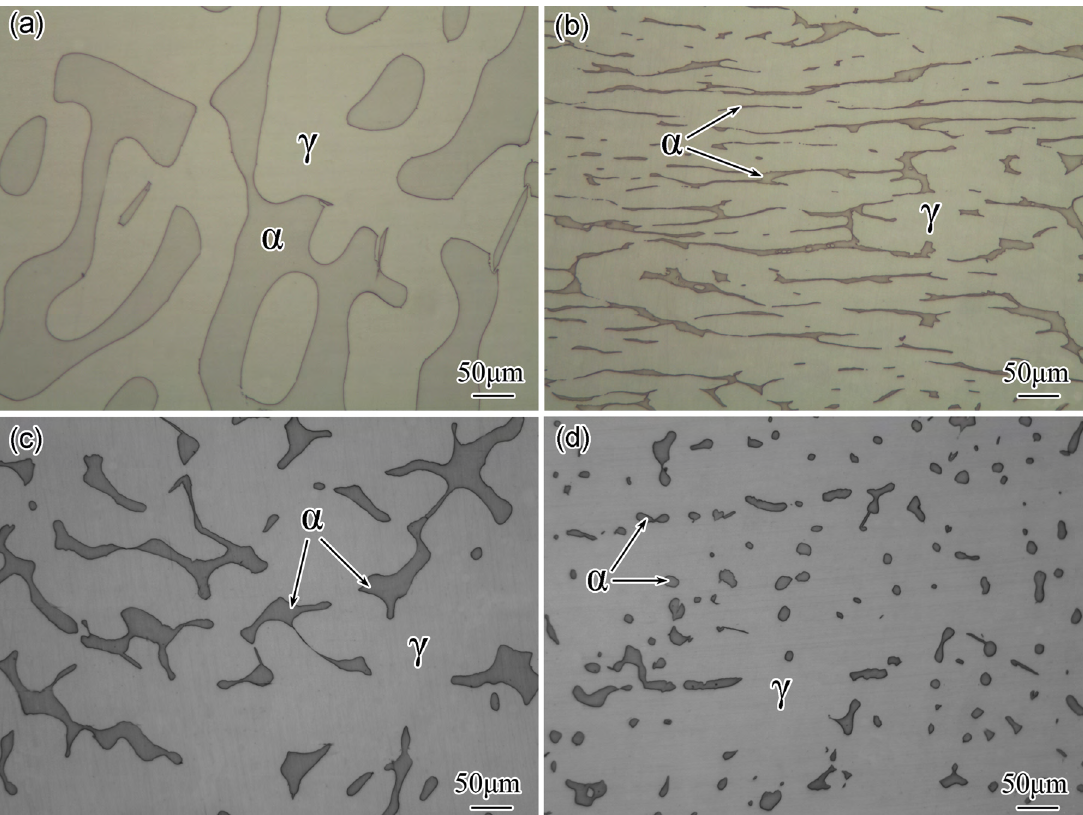
Figure 2. Microstructure of Z3CN20.09M specimens with different ferrite phase (a) annealed at 1350 °C, (b) hot forged, (c) containing 13% volume ferrite, (d) containing 8% volume ferrite, these specimens are named A, B, C, D respectively.